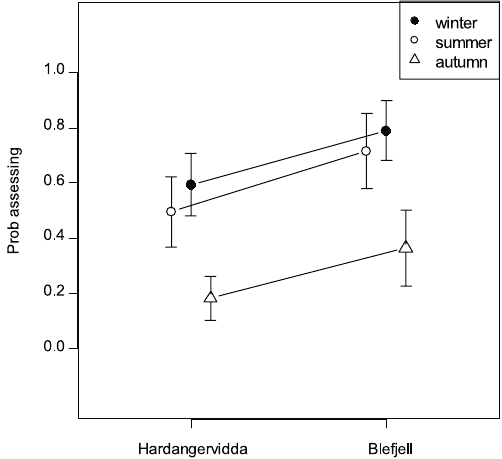
Fig. 3. The probability of assessing the observer before flight in reindeer groups in Blefjell and Har- dangervidda south central Norway in three seasons.